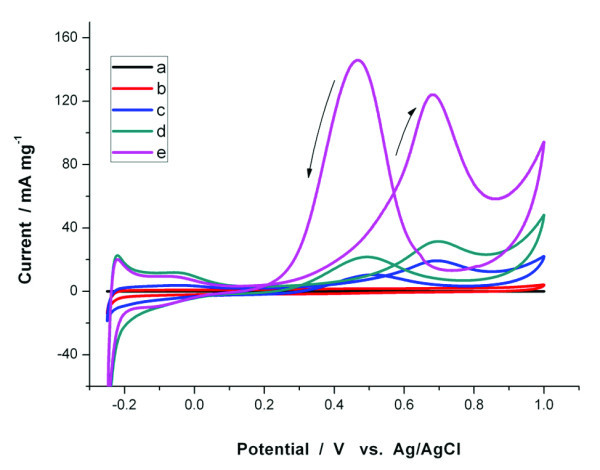
Cyclic voltammetric curves for the electrooxidation of methanol (sweep rate: 50 mV s-1, 0.5 mol L-1 H2SO4, 2 mol L-1 CH3OH, 298 K) with the following electrocatalysts. (a) graphene; (b) graphene/Au@Pt NRs; (c) graphene/Au@Pt0.34Ag0.66 NRs; (d) graphene/Au@Pt0.57Ag0.43 NRs; (e) graphene/Au@Pt0.64Ag0.36 NRs.